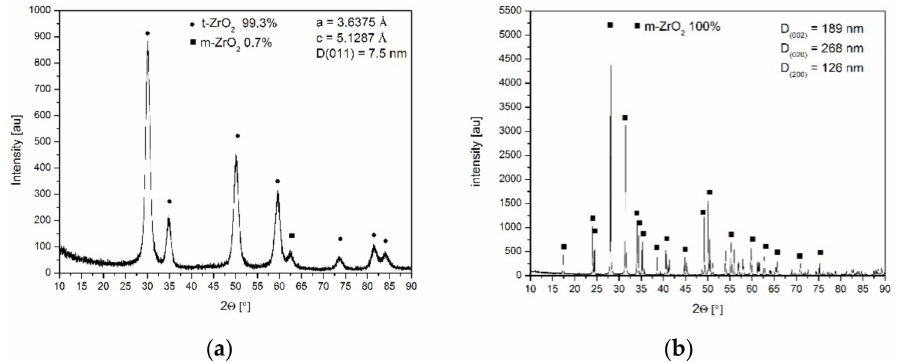
Figure 2. X-ray diffraction patterns of the constituent powders: ( a ) 3.5 mol% Y 2 O 3 -ZrO 2 powder crystallized in water, in majority tetragonal symmetry phase is present; ( b ) ZrO 2 powder crystallized in the NaOH solution, only monoclinic zirconia is